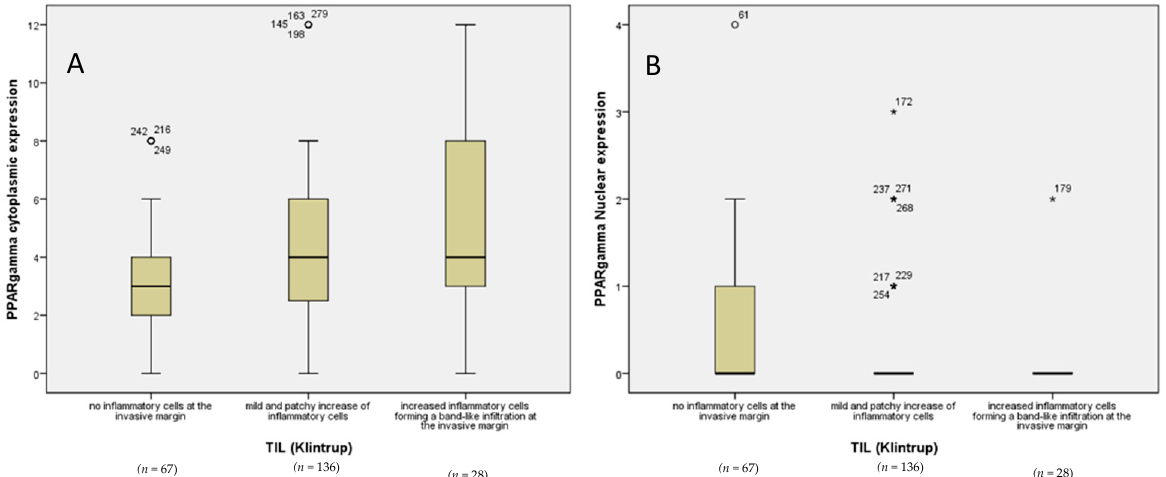
Figure 8. Expression of PPAR γ varies according to peritumoral inflammation. Cytoplasmic PPAR γ is significantly higher in cases with peritumoral immune infiltration ( A ), whereas an inverse correlation is observed with the levels of nuclear PPAR γ ( B ). Mild outliers are marked with a circle ( ○ ) on the boxplot. Extreme outliers are marked with an ( ★ ) on the boxplot.